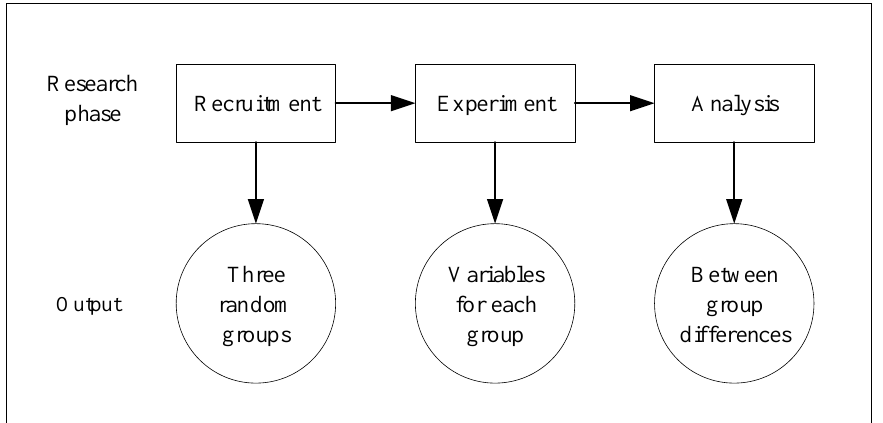
Figure 1. Research process